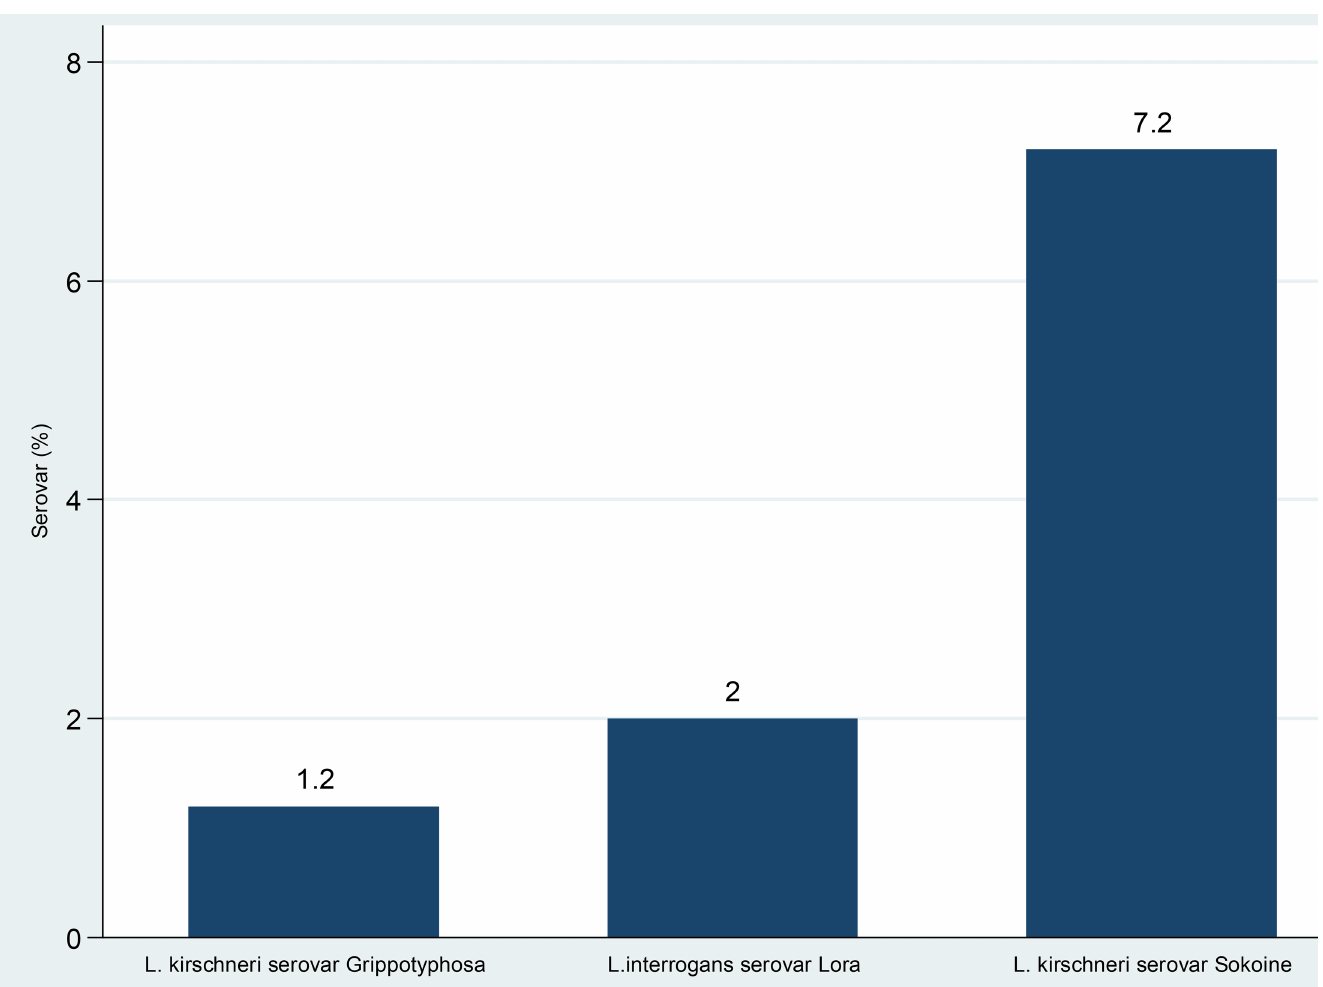
Fig 2. Seropositivity of Leptospira serovars among abattoir workers and meat vendors in Mwanza